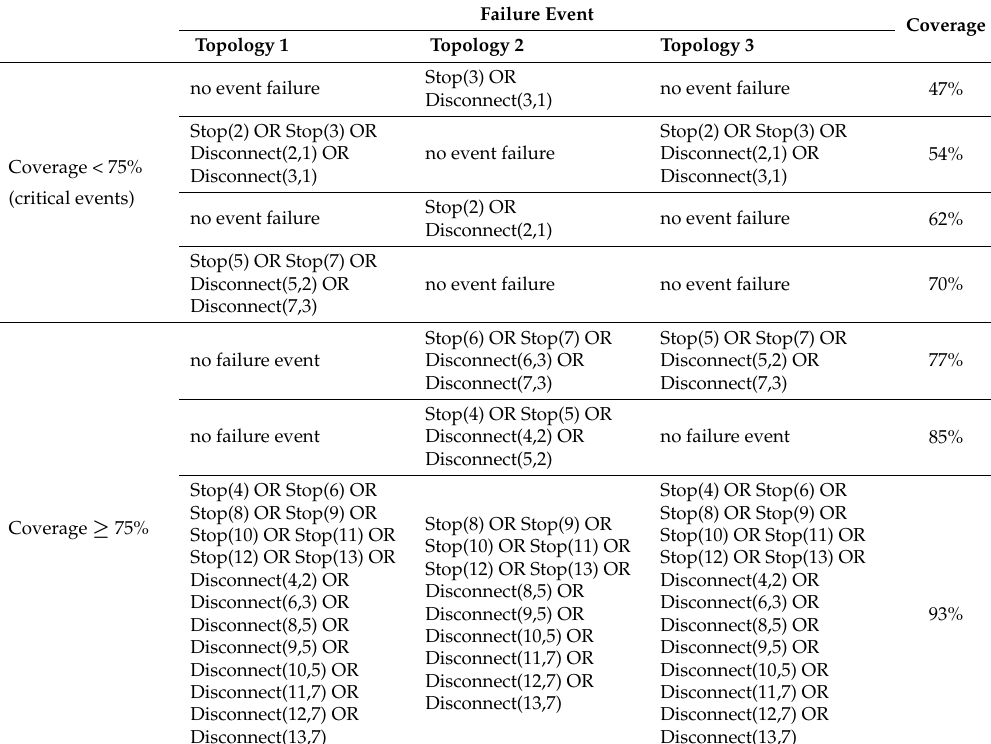
Table 4. Classification of failure events for a self-powered WSN (Topology 1, 2 and